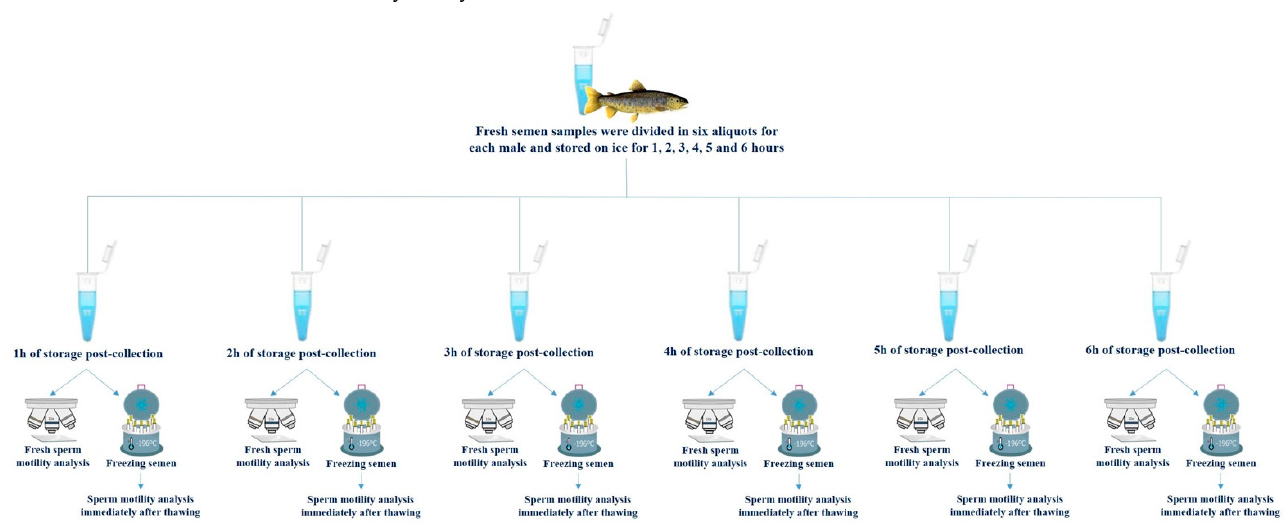
Figure 2. In vitro experimental design. Figure 2. In Vitro experimental